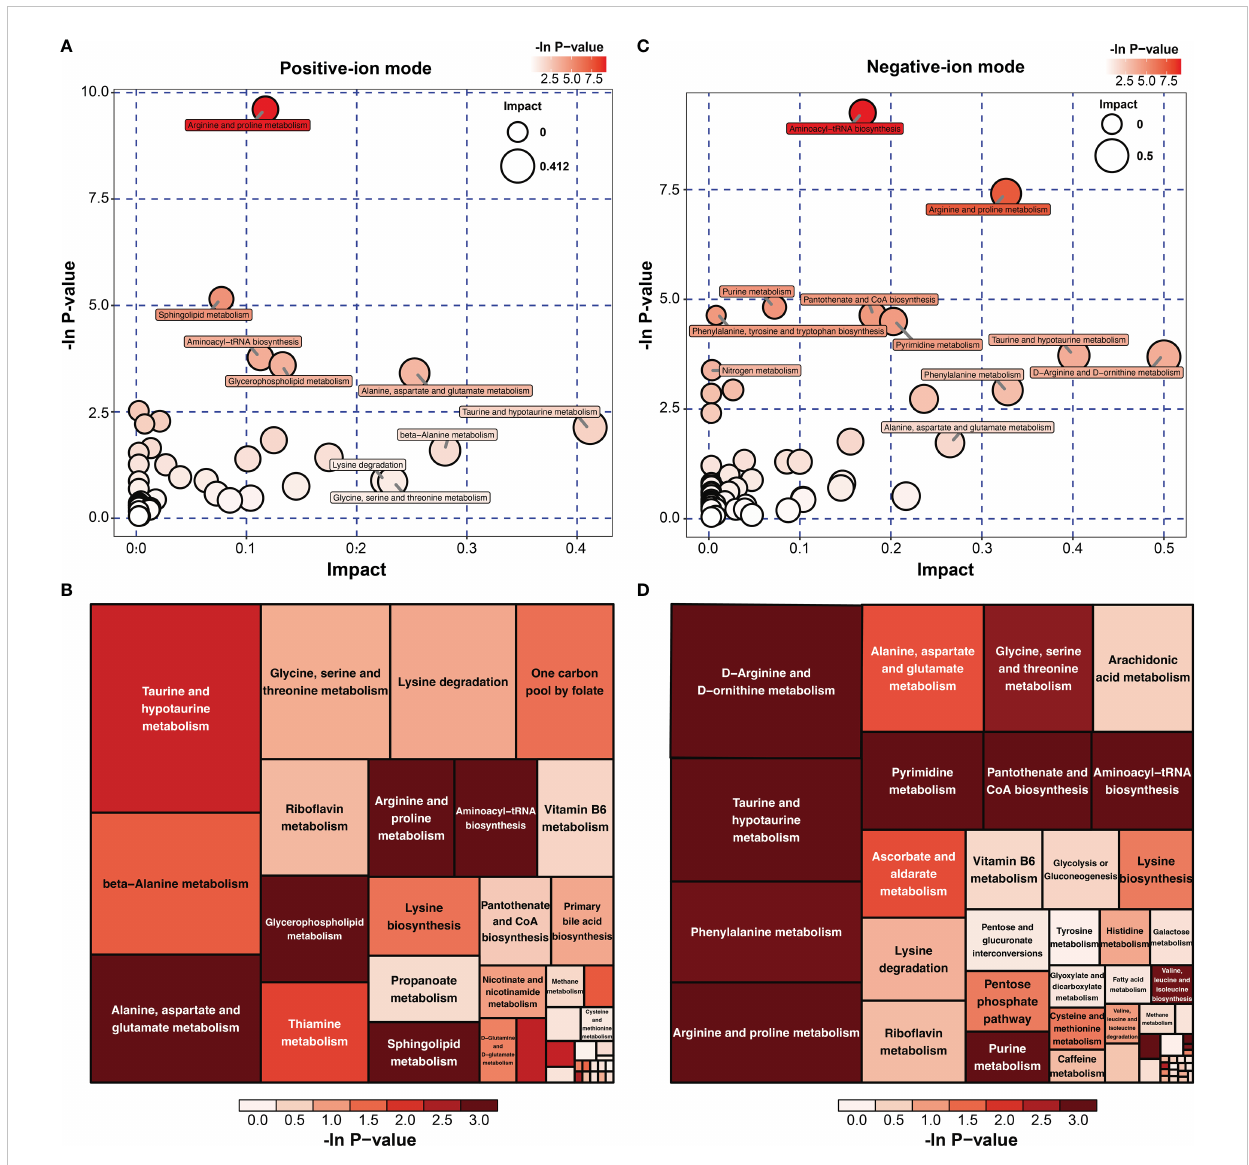
FIGURE 4 KEGG pathway analysis of differential metabolites (DMs) between HUVECs and HemECs by nontargeted metabolic analysis. (A, C) Bubble plot analysis of pathways. Each related metabolic pathway is shown as a circle, in which the size and color are based on the pathway impact value and the P value, respectively. (B, D) Treemap plot analysis of pathways. Each related metabolic pathway is shown as a rectangle, in which the size and color are based on the pathway impact value and the P value, respectively.